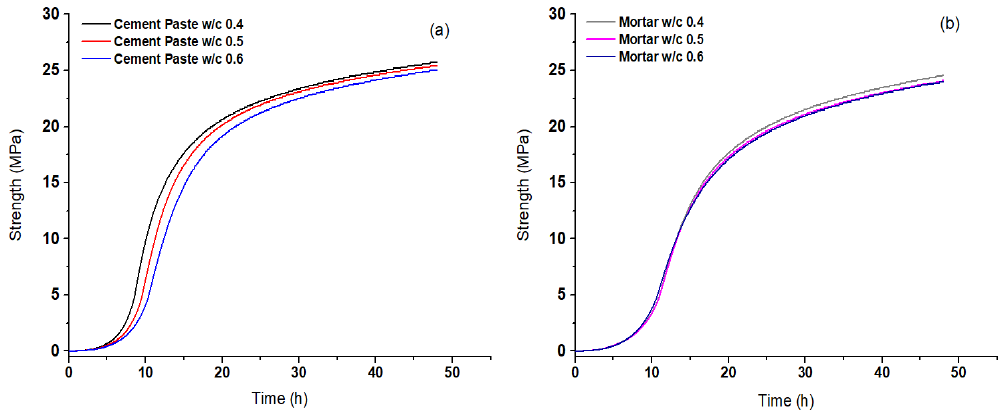
Figure 4. Strength values for different w/c ratios for ( a ) cement paste and ( b ) mortar.